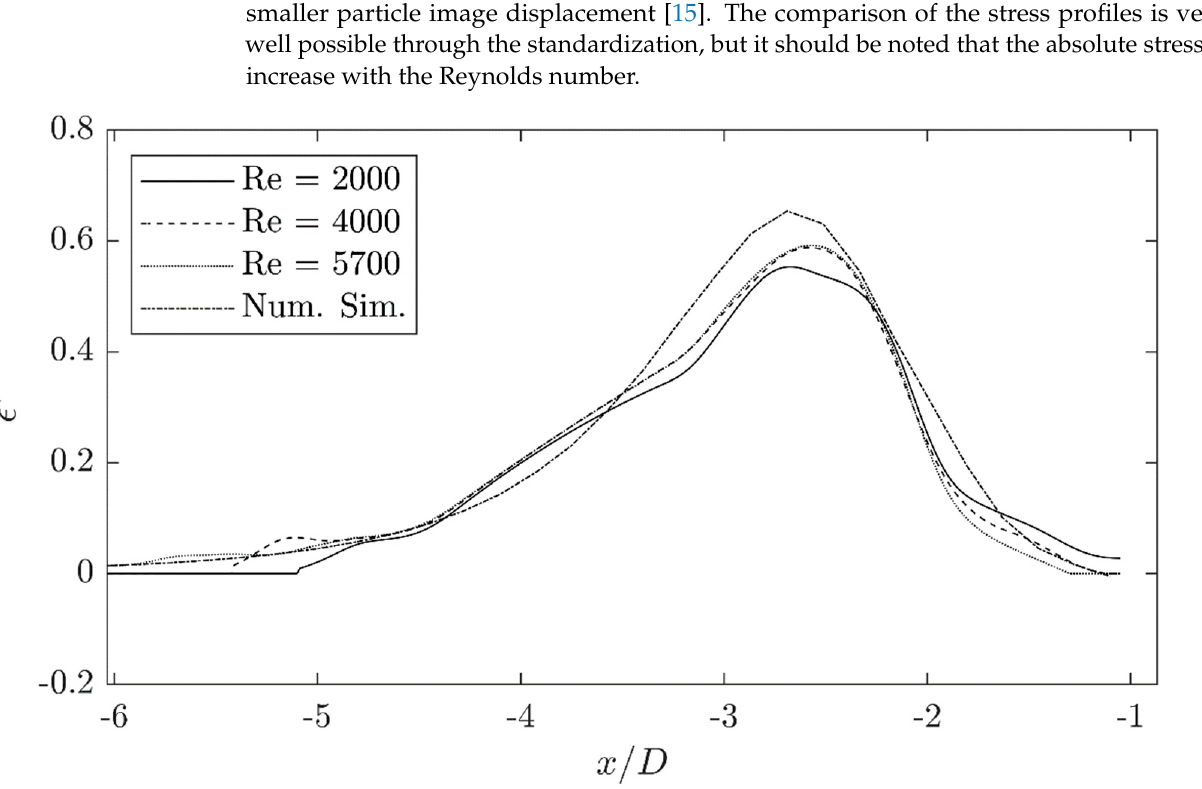
Figure 9. Dimensionless elongational rate profiles on the axis of symmetry of the orifice for three Reynolds numbers.